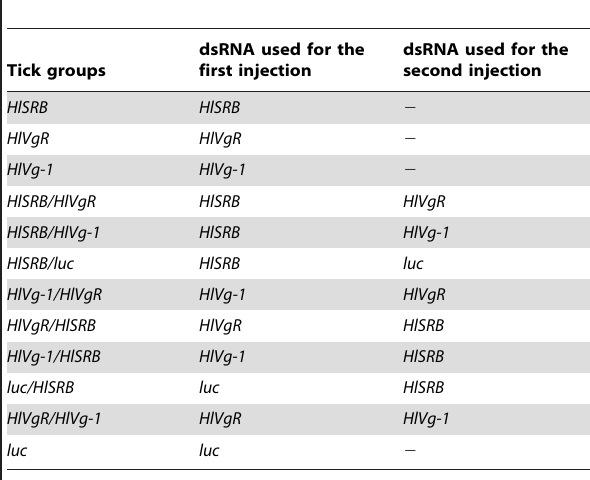
Table 1. Female tick groups injected with a single and a combination of